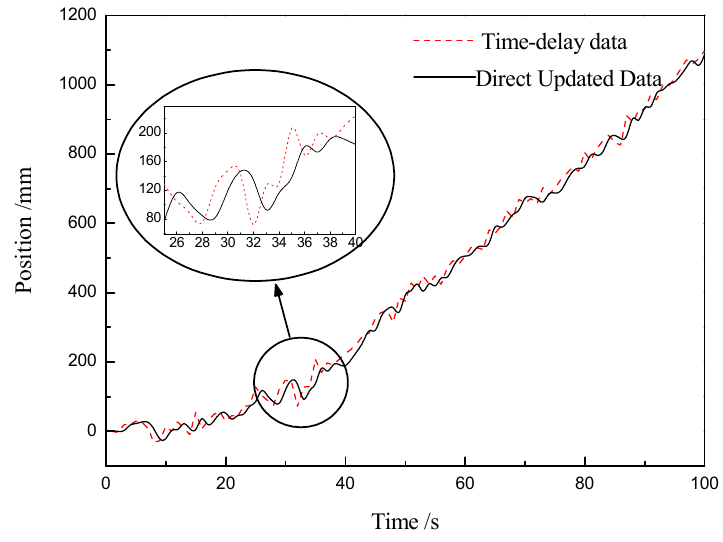
Figure 4. Direct update of time-delay data.